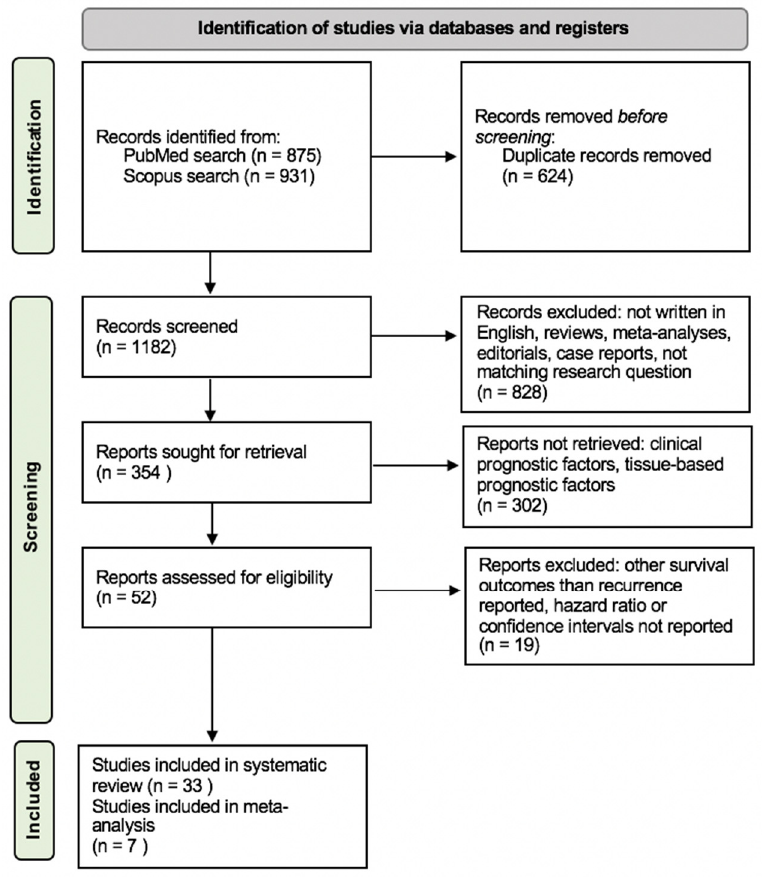
Figure 1. Preferred Reporting Items for Systematic Reviews and Meta-Analyses (PRISMA) 2020 flow diagram. From: Page et al. [25].